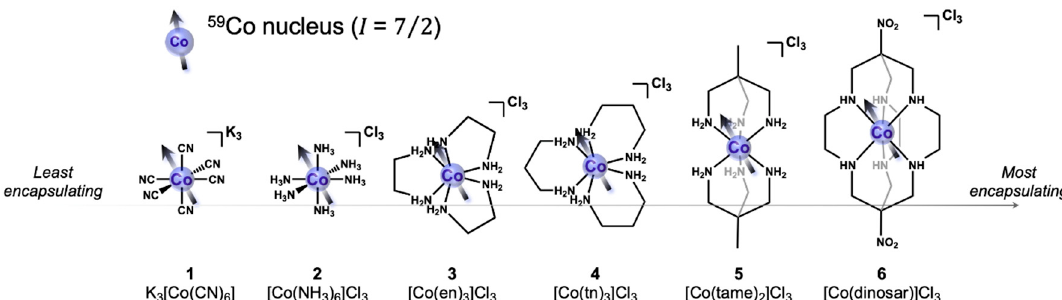
Figure 1. Chemical structure series of low-spin octahedral cobalt(III) complexes. Complexes 2–6 make up the series of progressively encapsulated 59 Co nuclei by greater degrees of chelation in a common Co–N 6 coordination environment. Arrows represent the I = 7 / 2 nuclear spin of the 59 Co nuclei in each complex. Hydrogens bound to carbons are omitted for clarity.